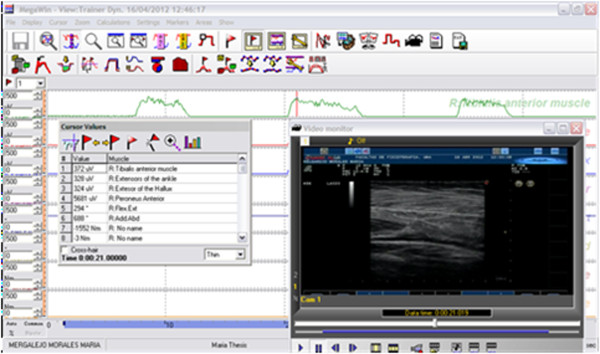
Synchronization example of ultrasound images and sEMG muscle activity.